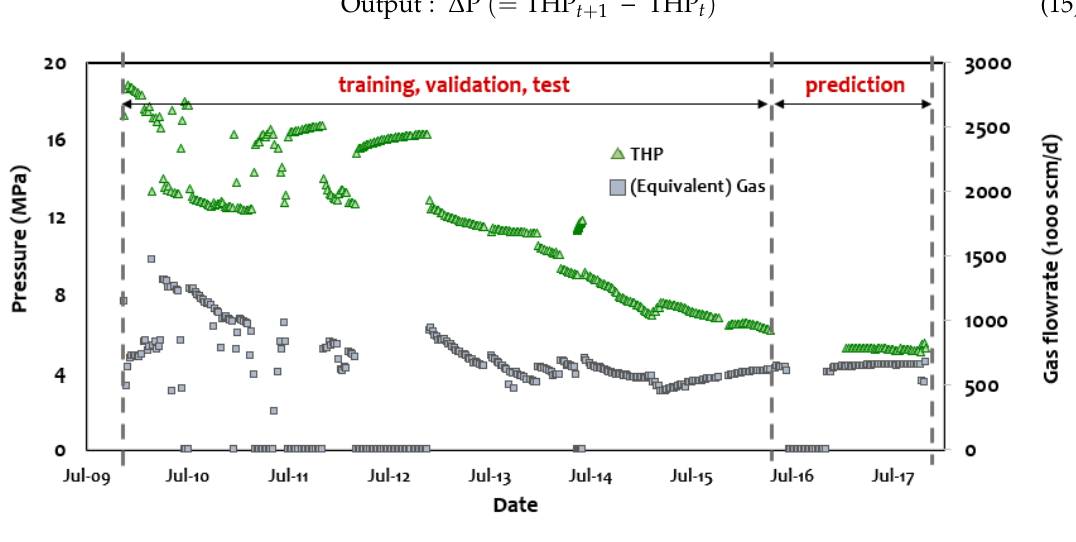
Figure 10. Revised dataset in Process 2.